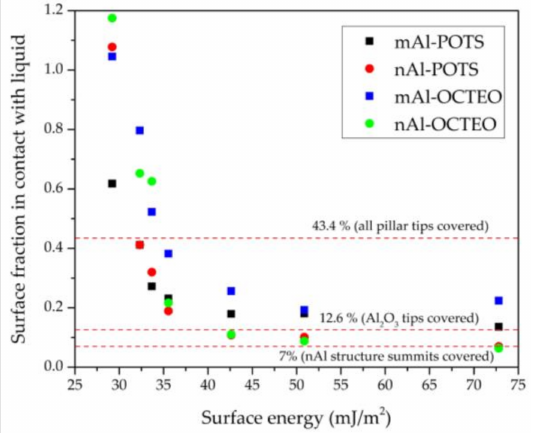
Figure 5. Wet surface fraction f 1 from Equation (2), calculated using the contact angles of a series of liquids with different surface tension. (red dot line is the percentage of solid-liquid